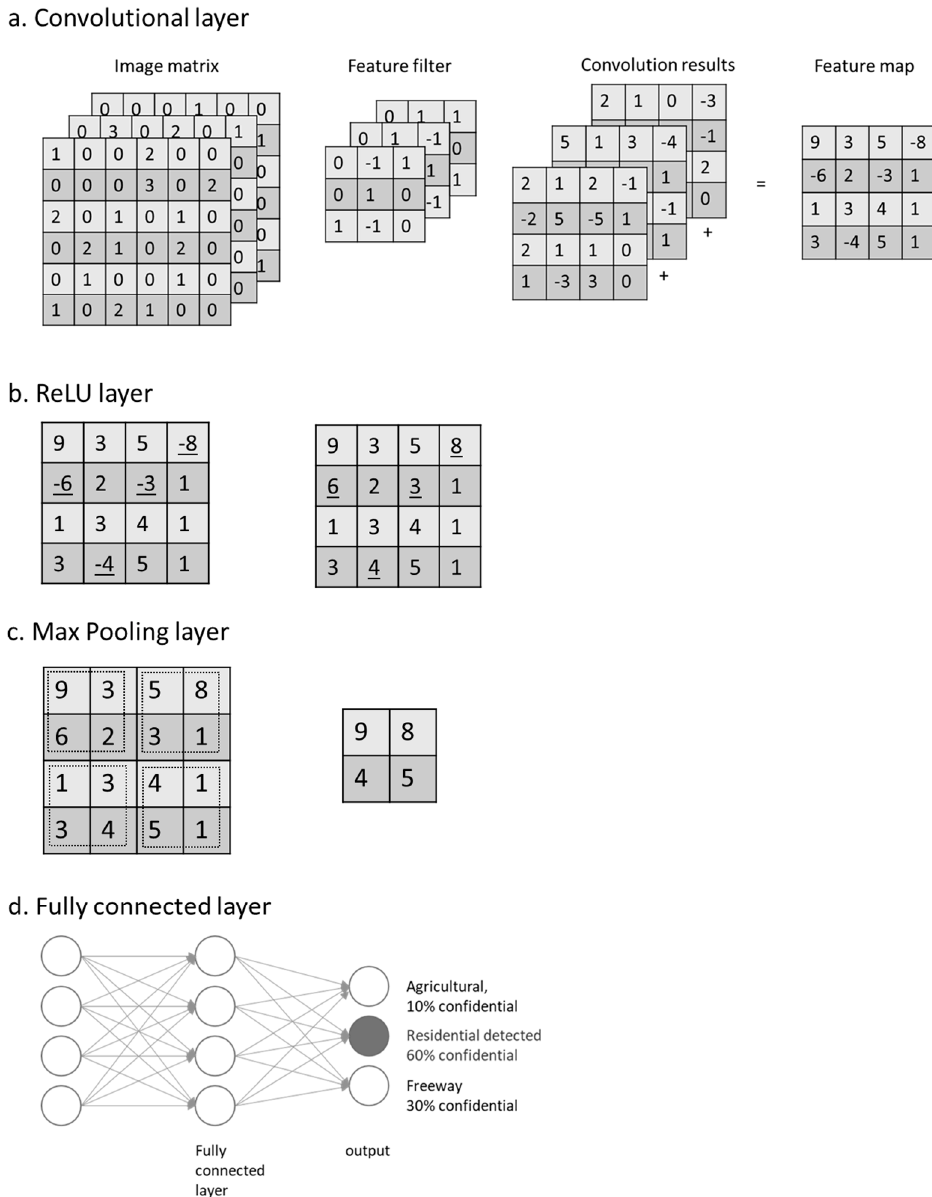
Figure 2. CNN layer functions—( a ) convolutional layer; ( b ) rectified linear unit layer; ( c ) max pooling layer and ( d ) fully connected layer.